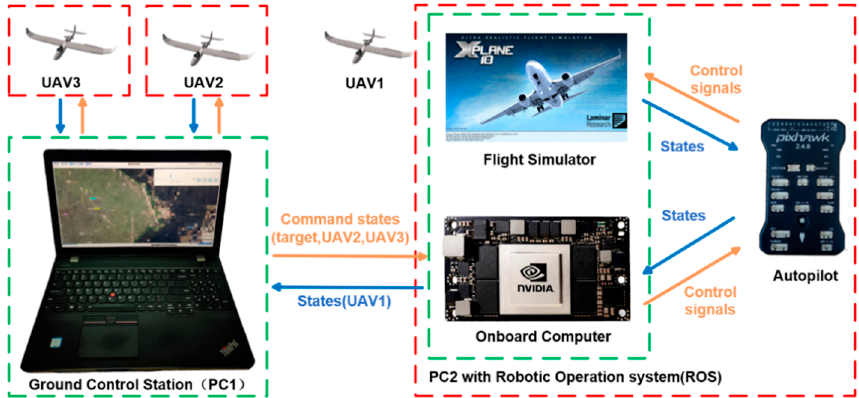
Figure 16. The architecture of the HIL simulation. The left part shows the Ground Control Station, and the right part places the detailed components (flight simulator, autopilot, and onboard computer) and the information flow among them. The modules are operated or connected in the robot operation system (ROS).